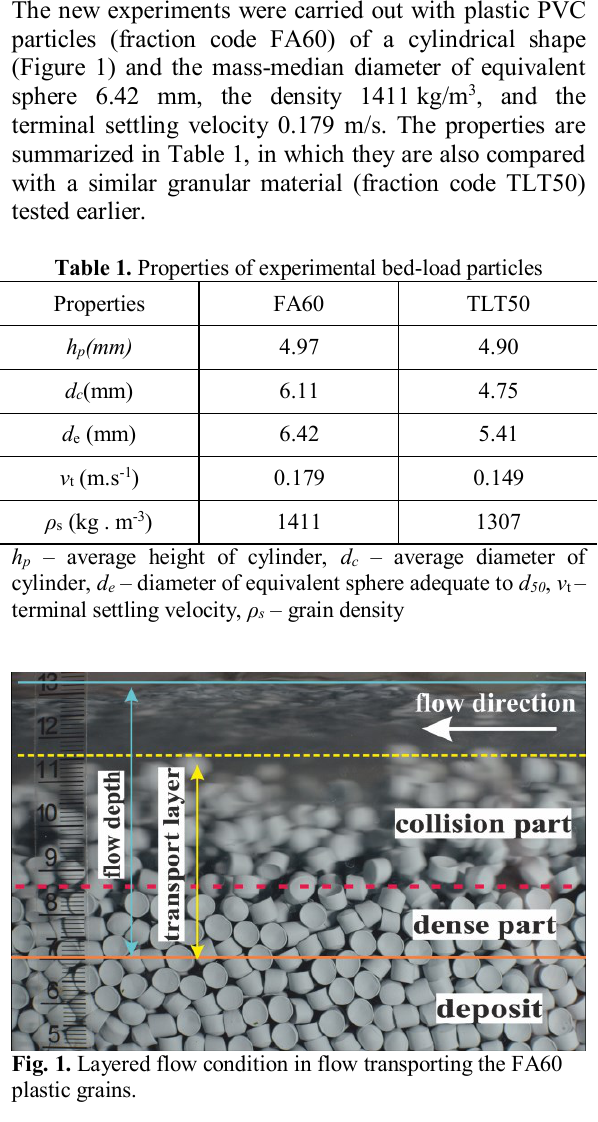
Table 2. Range of integral quantities of flow in